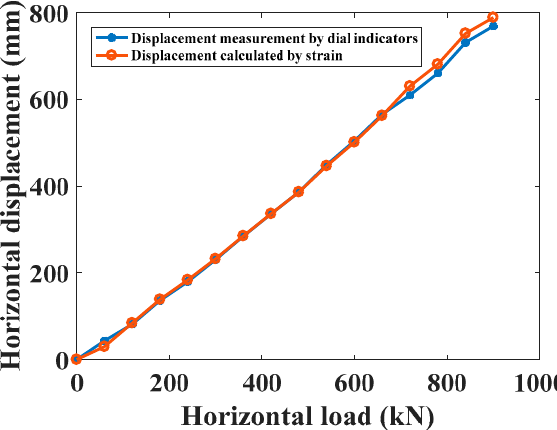
Figure 12. Displacement data at +10 m elevation collected by the dial indicators compared with displacement data obtained by the distributed strain calculation under horizontal loads.